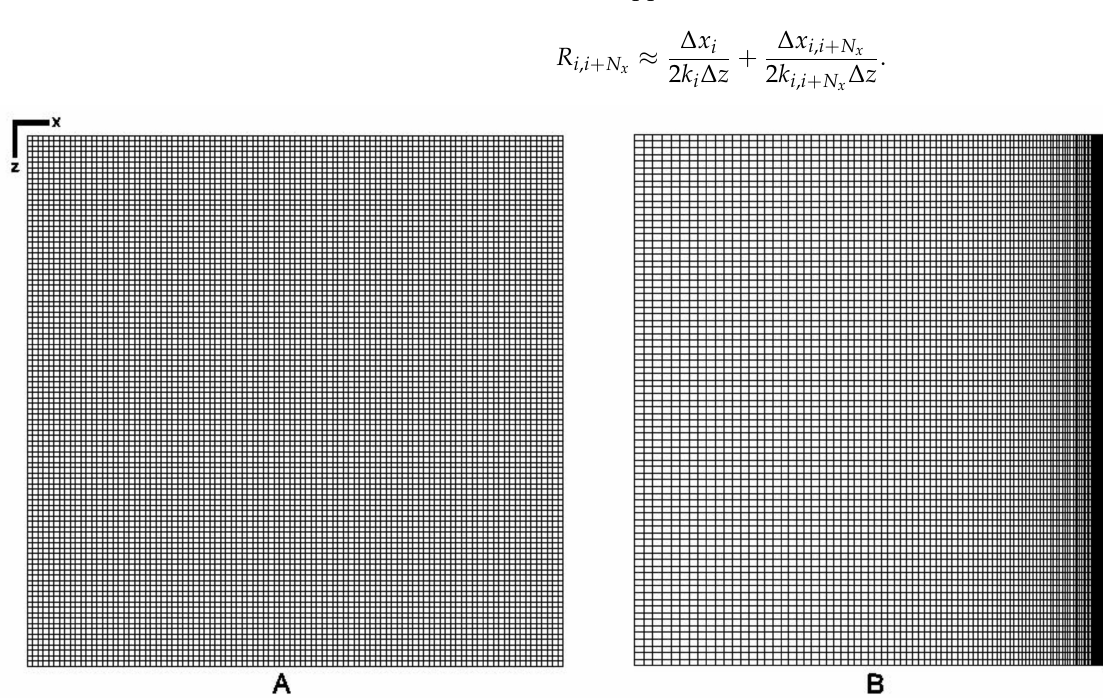
Figure 6. ( A ) Equidistant mesh. ( B ) Gradual change in the x